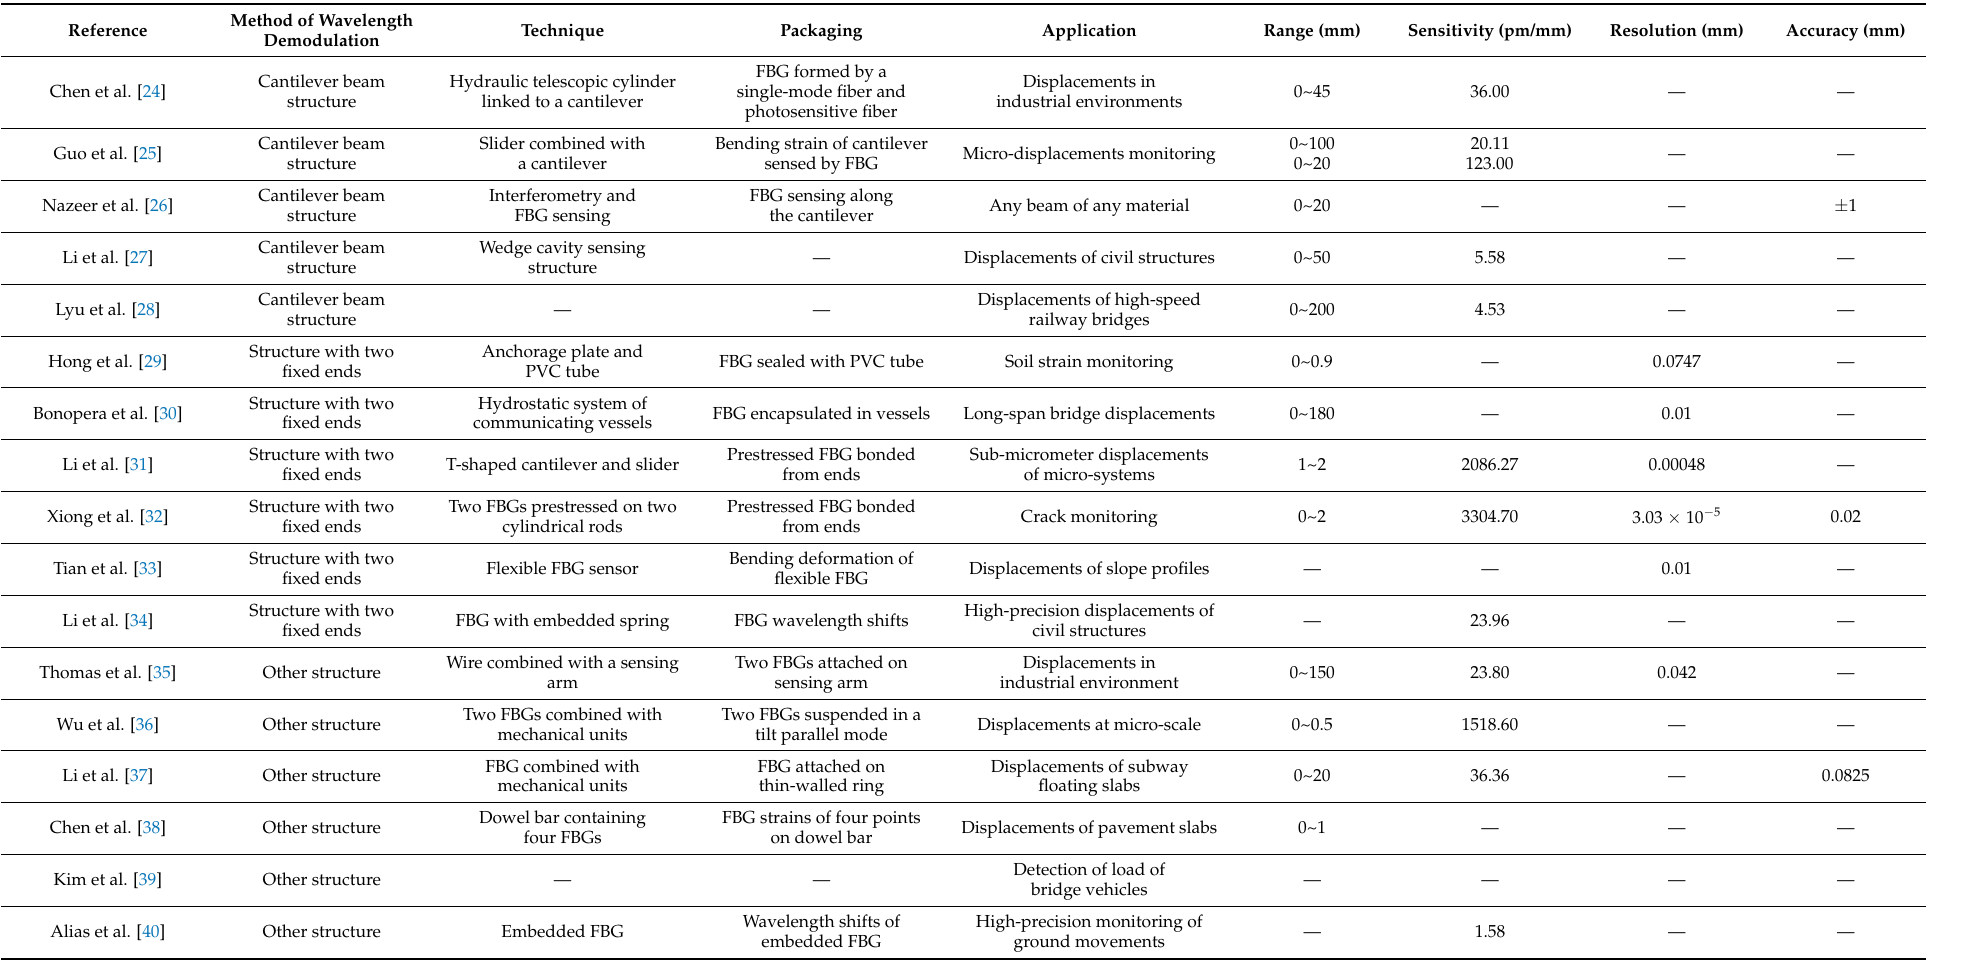
Table 1. Applications and performances for FBG-based displacement sensors according to wavelength shift demodulation (Section